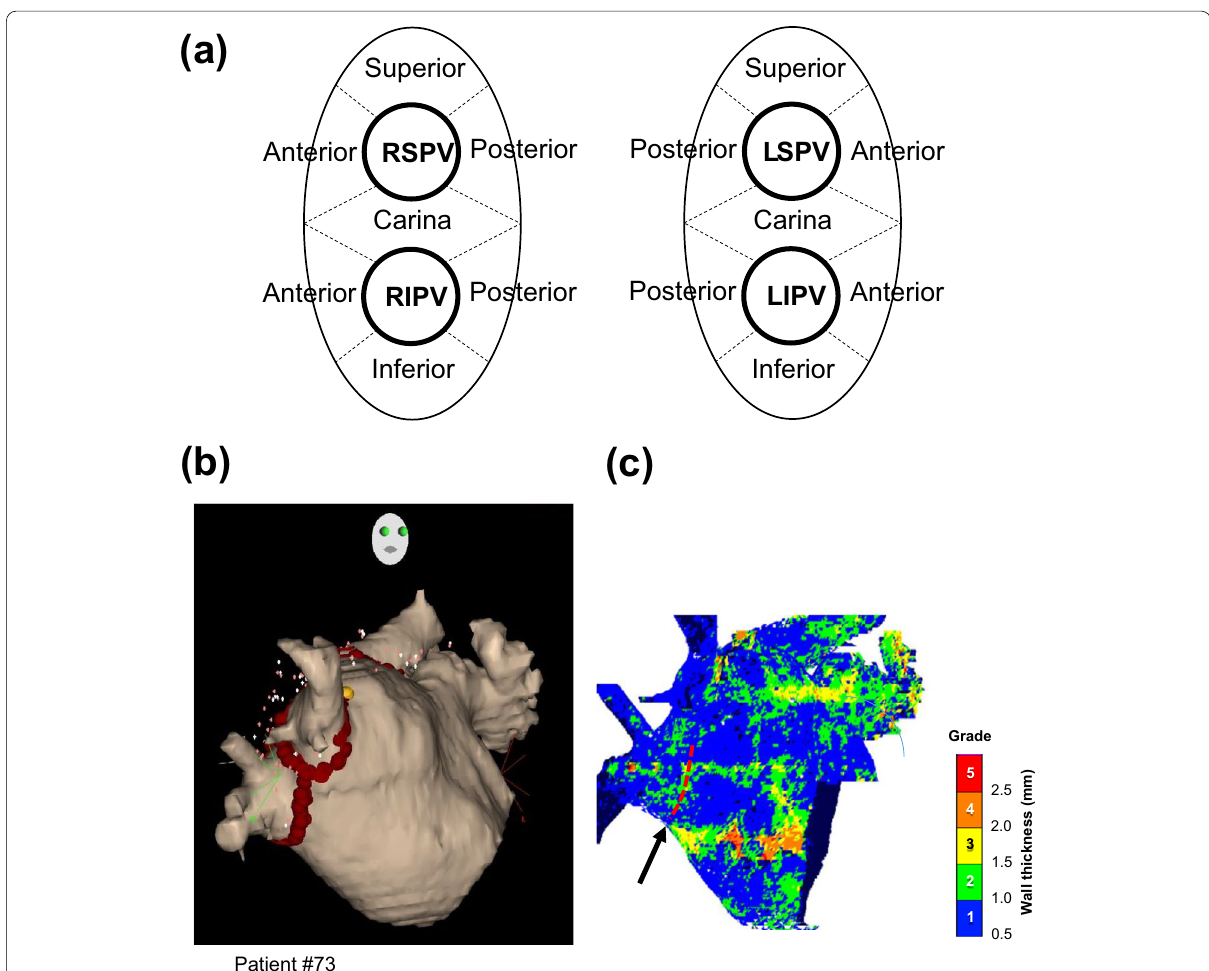
Fig. 2 Analysis of ablation lines. a Classification of segments of PV antrum from endocardial view. Diagrams were generated by PowerPoint 2016 (Microsoft, Redmond, WA). Ablation line to analyze on the CARTO system b was matched with the wall thickness map ( c ). A red dashed line (arrow) indicates the ablation line on the anterior segment of RIPV antrum. Green‑colored areas are the highest AWT grade with about 75% (> 25%) of the length of the ablation line, thus AWT of the anterior segment of RIPV antrum is grade 2 in this patient. LSPV left superior PV, LIPV left inferior PV, RSPV right superior PV, RIPV right inferior